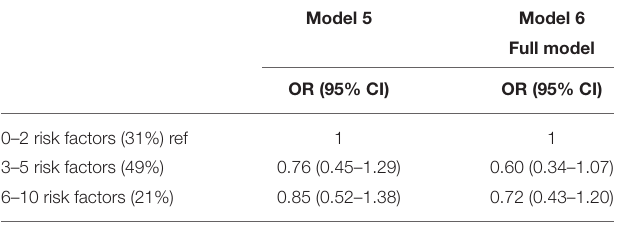
TABLE 4 | Odds ratios and confidence intervals for the association between adolescent cumulative risk and indication of substance use problems 3 years after initiation of treatment ( n =